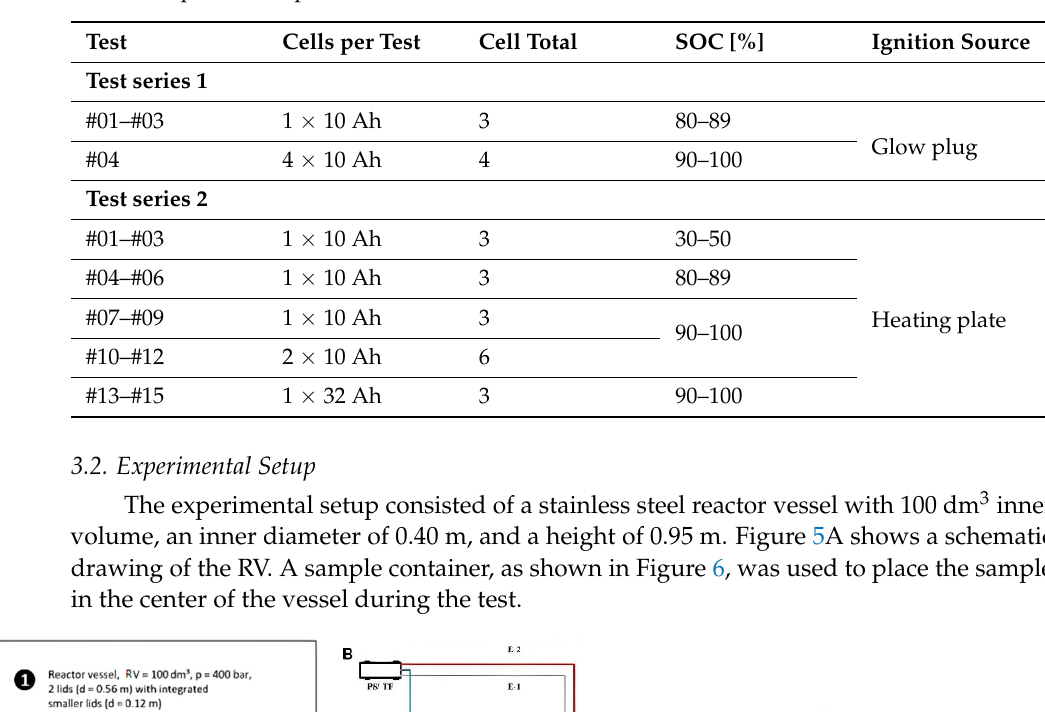
Table 6. Experimental plan for Series 1 and 2 tests.